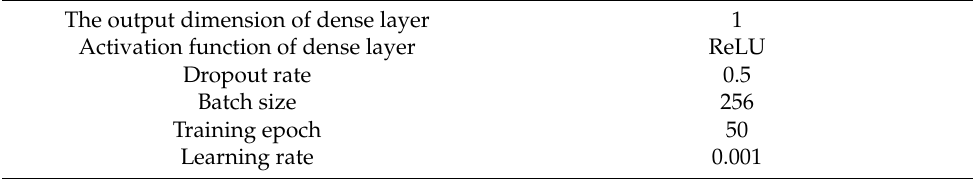
Table 2. Specifications used for network training.